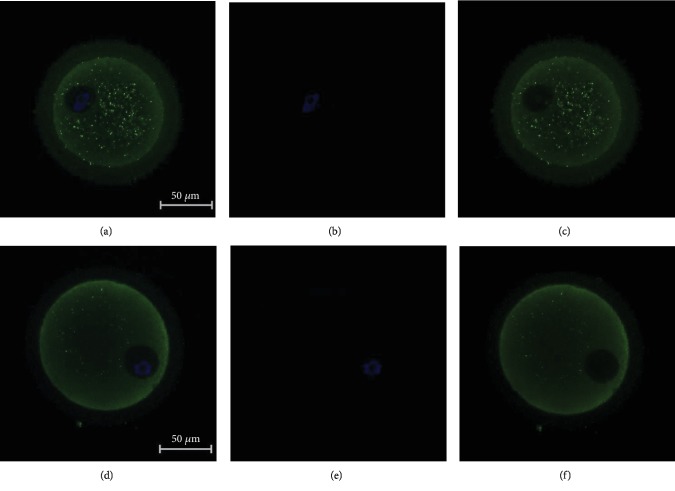
Immunofluorescence staining for detecting the expression pattern of GJA1 in human oocyte with and without PCOS at GV stage. (a–c) Oocyte from women without PCOS. (d–f) Oocyte from PCOS women. Oocytes were counterstained with the cytoskeleton (green) and nuclei (DAPI, blue). Bar = 50 μm.